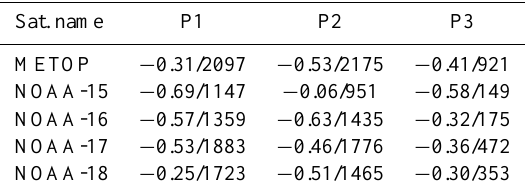
Table A2. Linear correlation coefficient/number of data points. The correlation coefficient between 0 ◦ /90 ◦ -flux ratio in the isotropic re- gion and the parameter representing the energy spectrum slope for corresponding energy band (see explanation in the